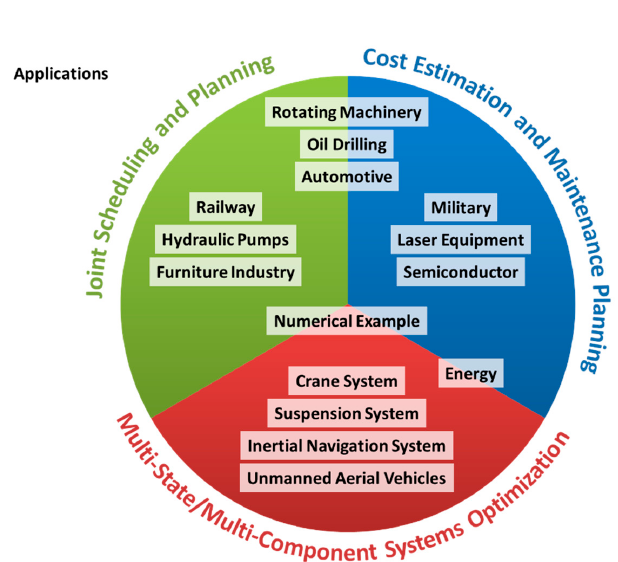
Figure 2. The categories of methods for each area of contribution.